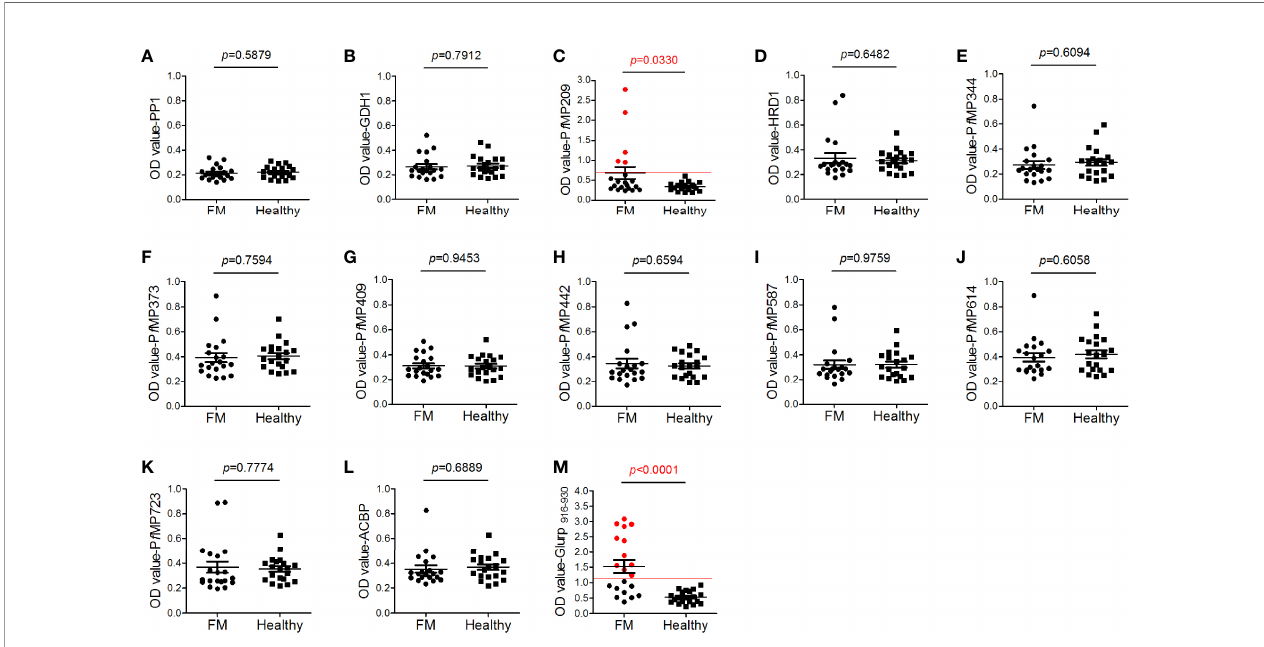
FIGURE 4 | Antigenicity of merozoite proteins. Human serum antibody levels against the merozoite proteins, including serine/threonine protein phosphatase 1 [PP1, (A) ], nicotinamide adenine dinucleotide phosphate (NADP)-speci fi c glutamate dehydrogenase [GDH1, (B) ], Plasmodium falciparum merozoite protein ( Pf MP) 209 (C) , endoplasmic reticulum-associated degradation (ERAD)-associated E3 ubiquitin-protein ligase 1 [HRD1, (D) ], Pf MP344 (E) , Pf MP373 (F) , Pf MP409 (G) , Pf MP442 (H) , Pf MP587 (I) , Pf MP614 (J) , Pf MP723 (K) , acyl-CoA binding protein [ACBP, (L) ], and glutamate-rich protein (Glurp, 915 – 930aa, M ), were determined by ELISA. A total of 20 sera from patients with falciparum malaria (FM) and 20 sera from healthy individuals (healthy) were tested. Red lines indicate the cutoff values of the positive tests ( ≥ 2.1-fold the mean optical density value of the healthy group). Red dots indicate positive individuals. Data are presented as the median ± standard